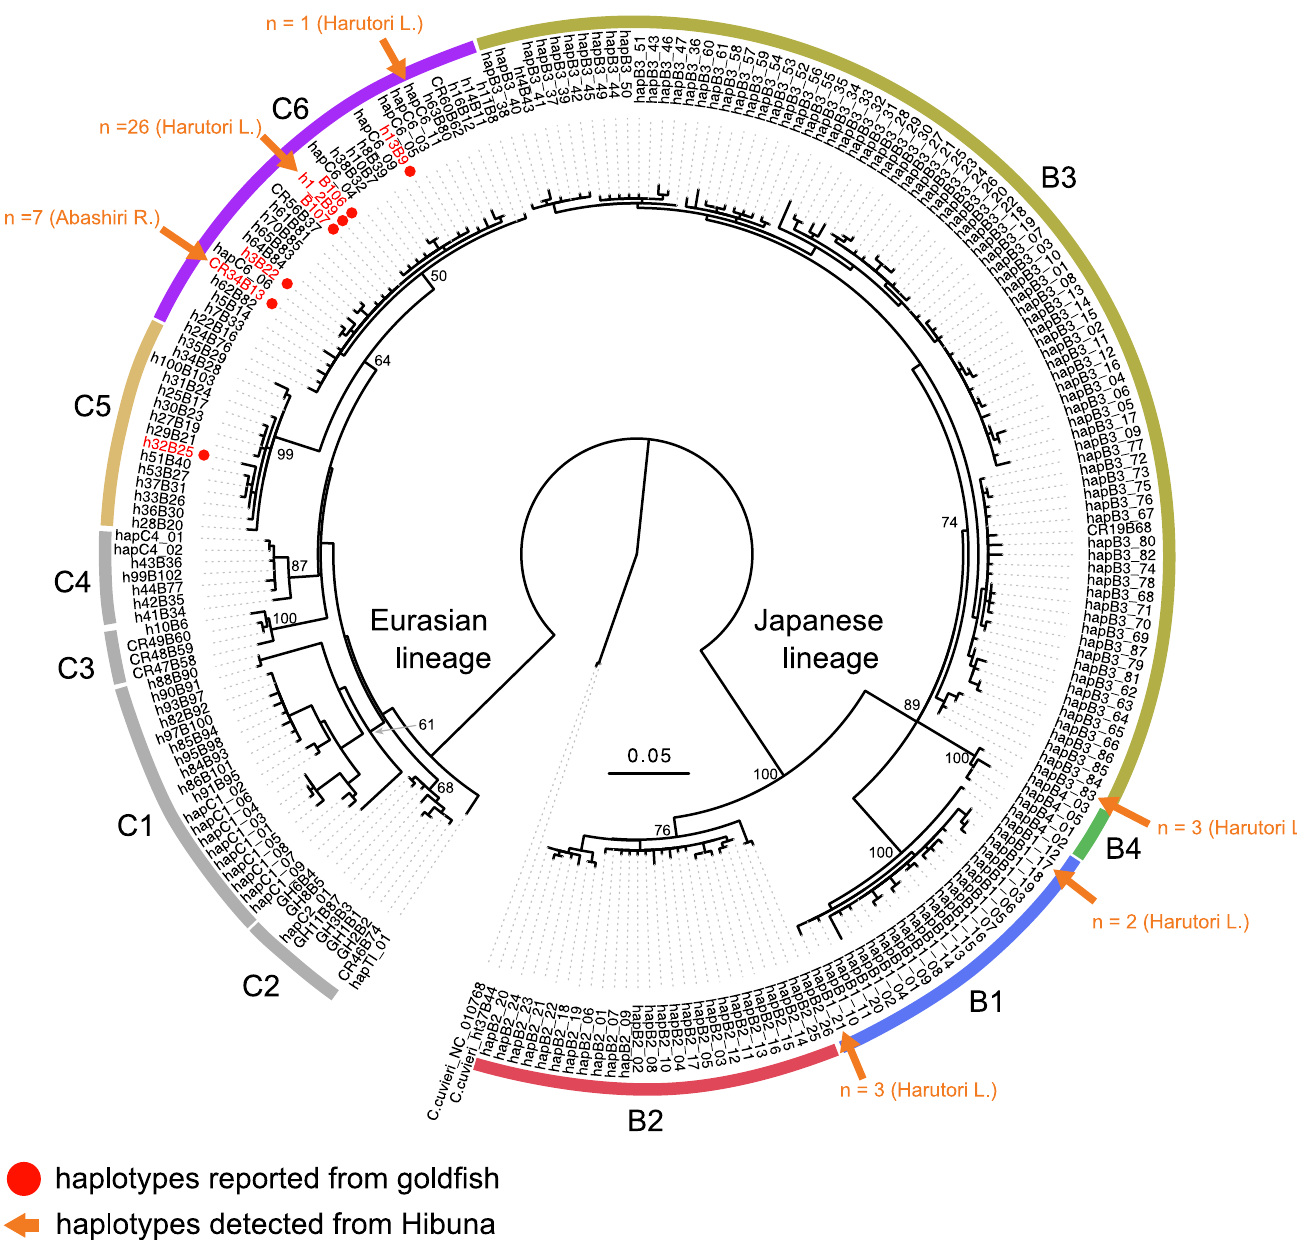
Fig 2. ML tree based on 885-bp sequences of mitochondrial cyt b region from 225 unique haplotypes of Carassius constructed using RAxML. The mitochondrial haplotypes previously reported from goldfish are colored in red circles. Scarlet arrows indicate haplotypes detected from Hibuna.